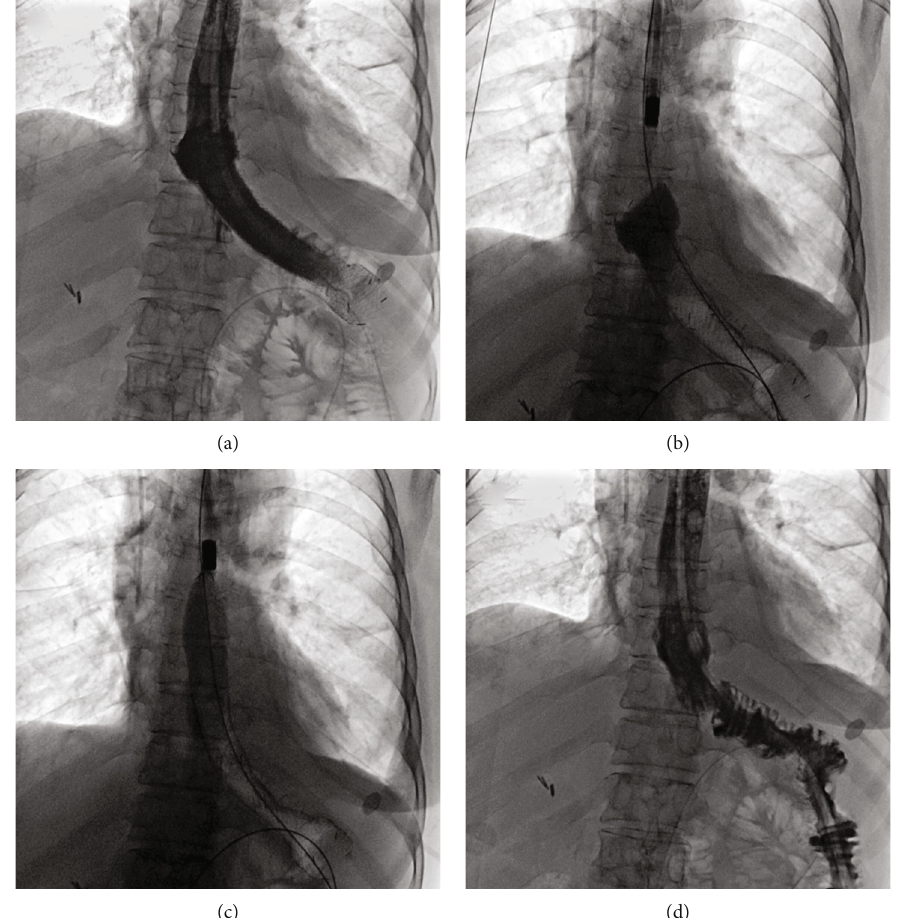
Figure 4: Stent removal for case 16. (a) Esophagography shows that the contrast agent fl ows though the covered stent with no leakage 45 days after stent placement. (b, c) The stent was removed under fl uoroscopic guidance. (d) After removal of stent, esophagography showed that the contrast agent fl owed through the esophagus with no